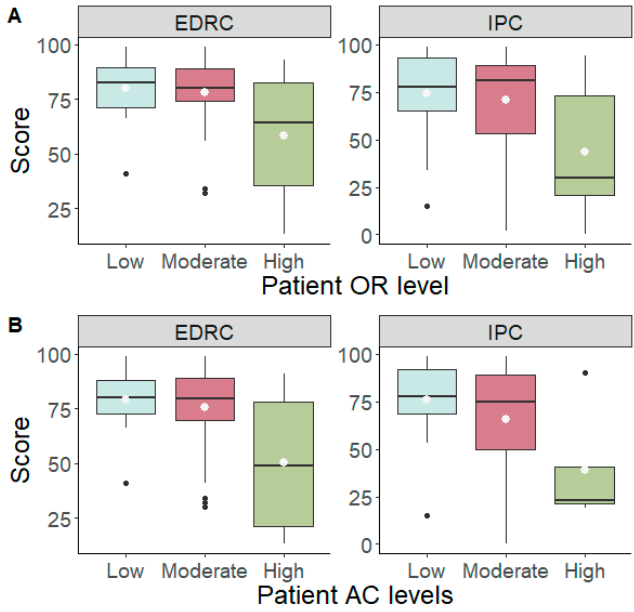
Figure 3. Significances between OR ( A ) and AC ( B ) and both EDRC and IPC.